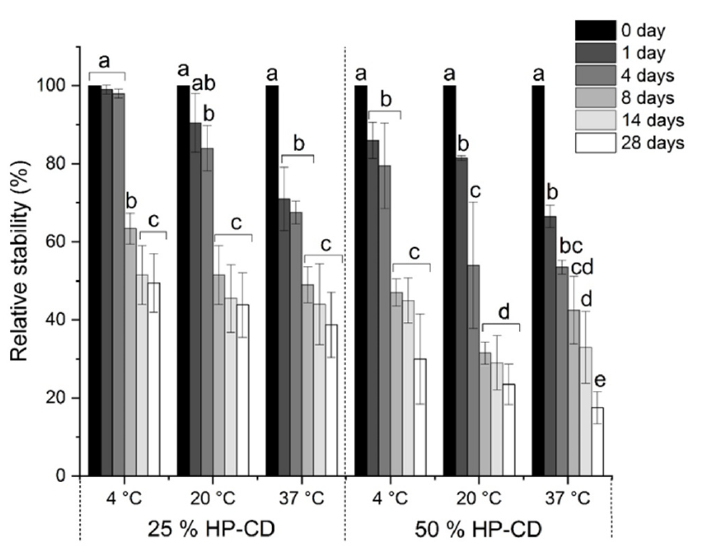
Figure 5. Relative stability of CAR in the CAR/HP-CD aggregates obtained using 25 and 50% HP-CD aqueous dispersions under the storage in the dark at different temperatures. Different letters indicate significant differences ( p < 0.05) of CAR stability within each group of stability data.